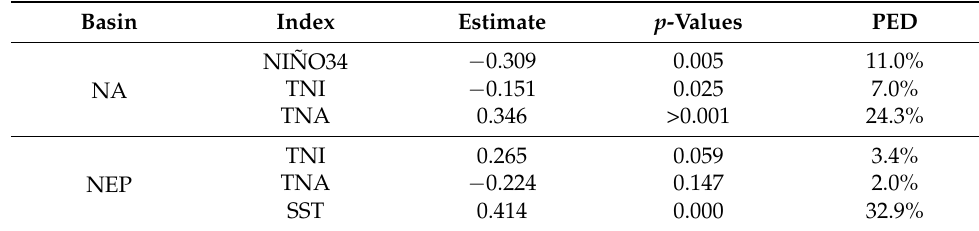
Table 2. Results from multivariate temporal analysis of MH occurrences.